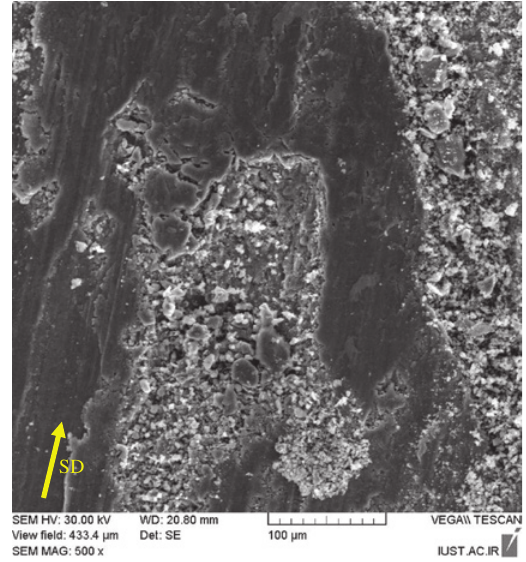
composite at peak p